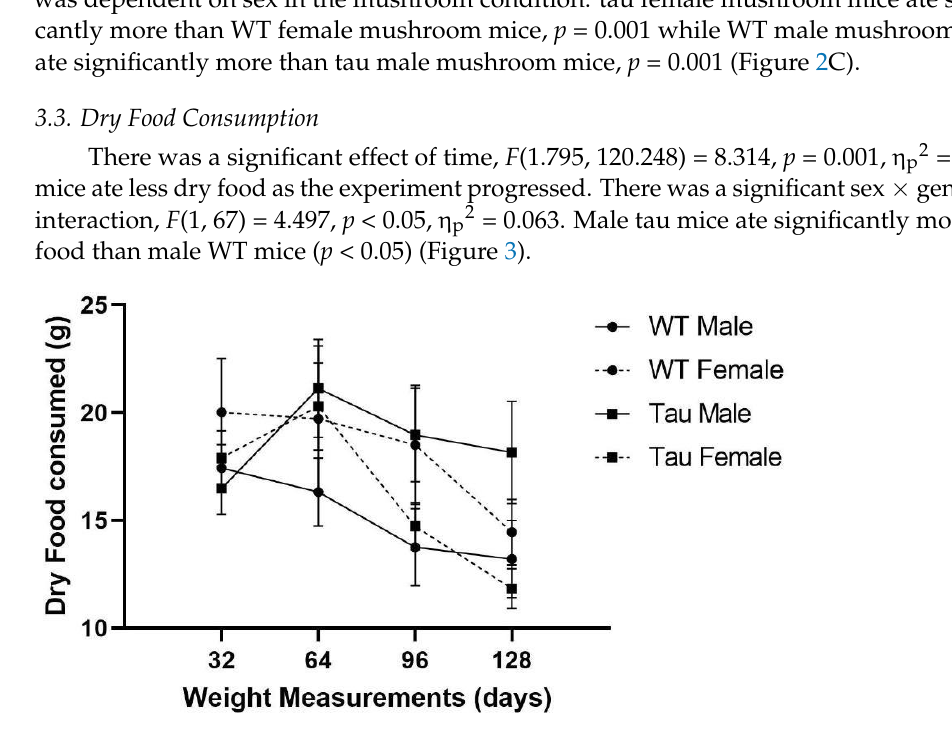
Figure 4. Open field test measures. ( A ) Tau control mice had significantly longer latencies to enter the center compared to WT control mice. Tau mice supplemented with H. erinaceus had significantly